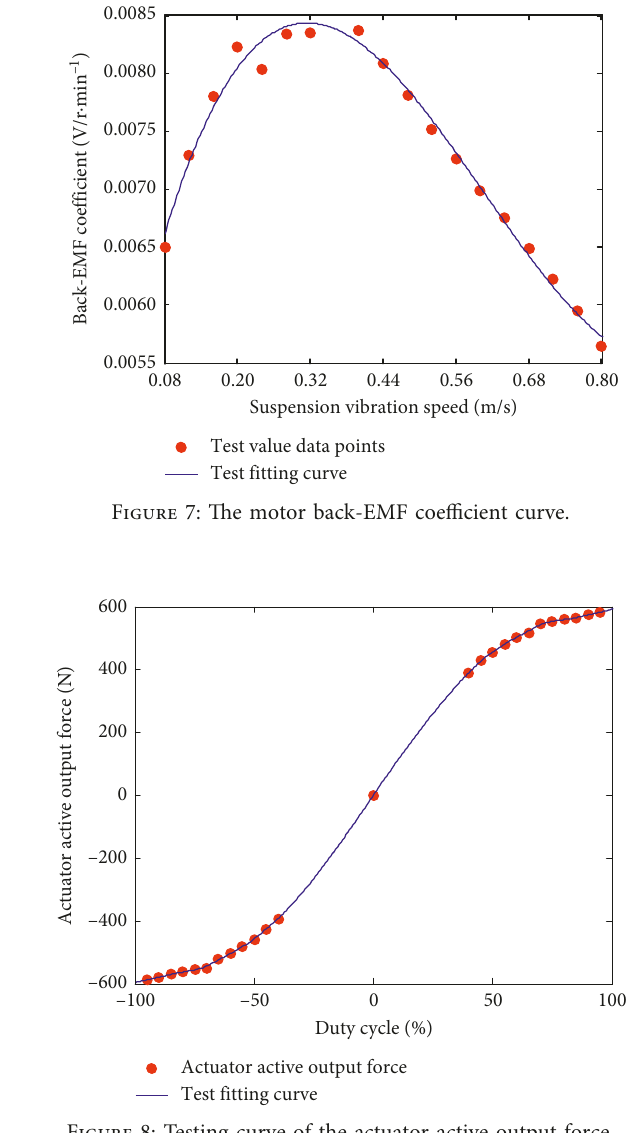
Figure 8: Testing curve of the actuator active output